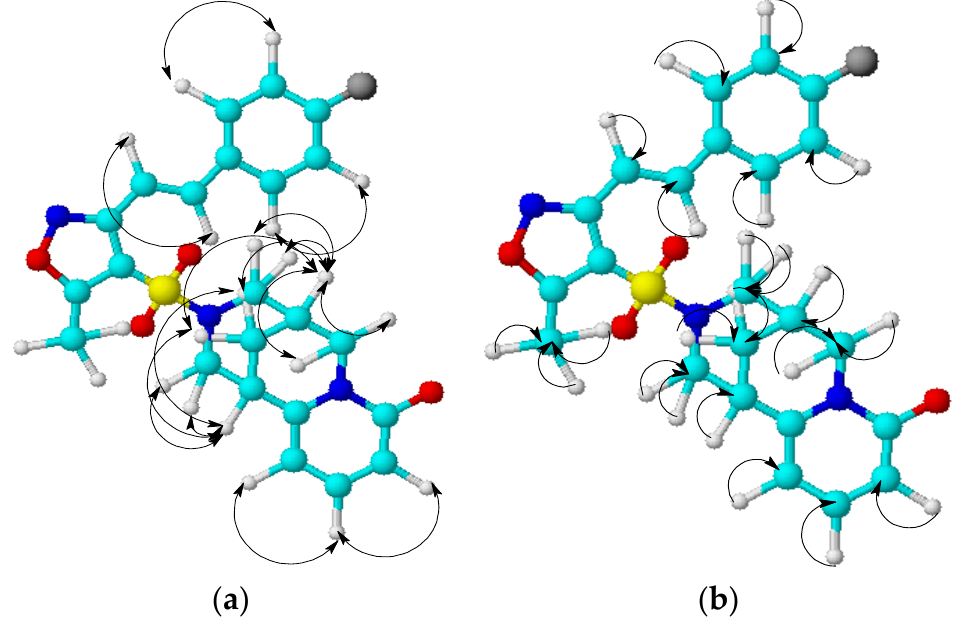
Figure 3. The structural correlations in the COSY ( a ) and HMQC ( b ) spectra of compound 3.